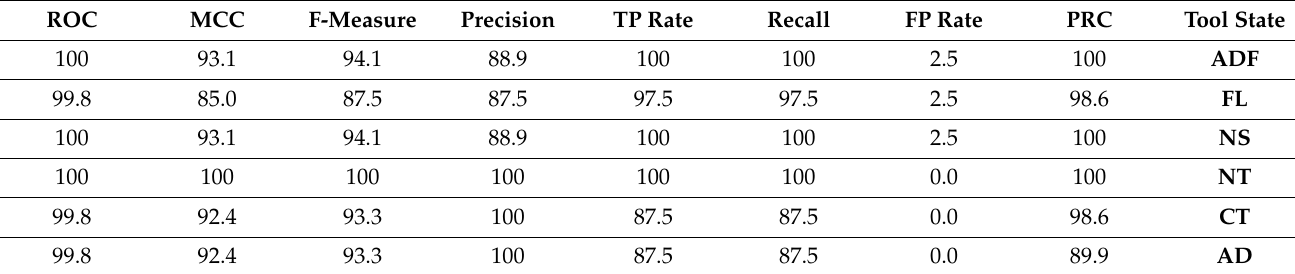
Table 7. Performance indicators of classification considering test dataset.